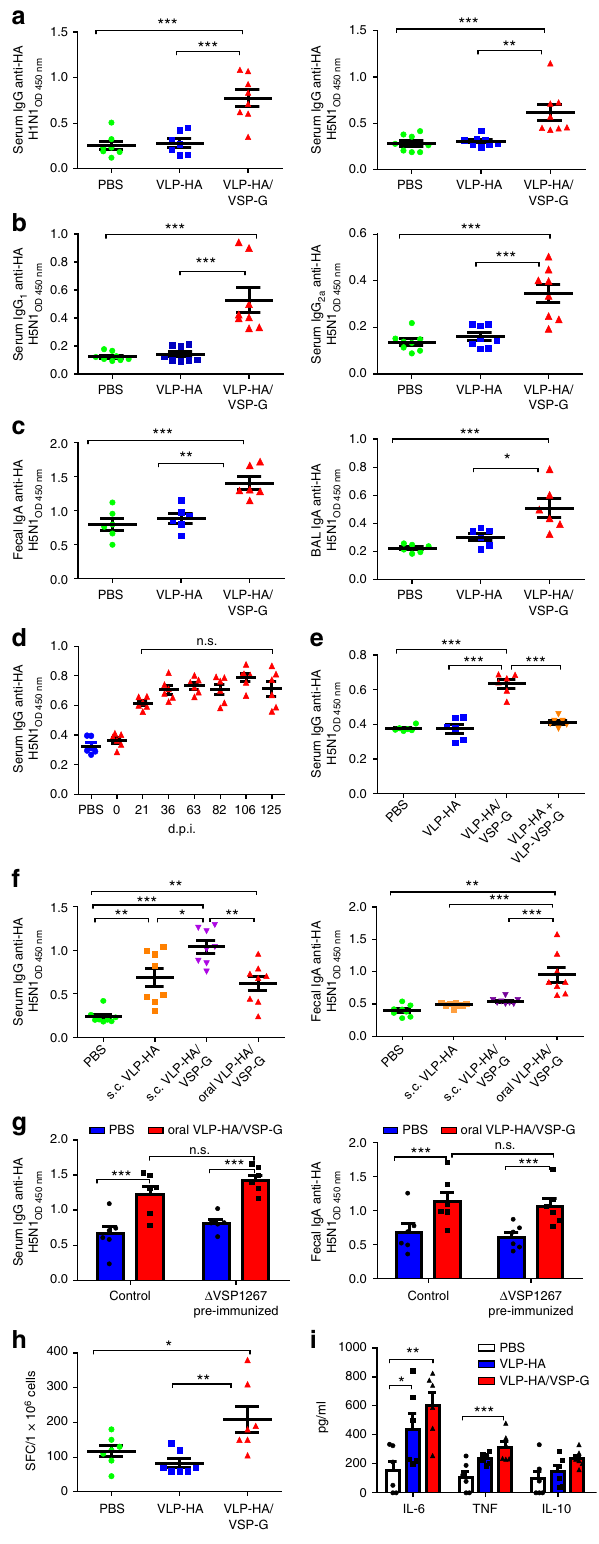
Fig. 5 Induction of anti-HA humoral and cellular responses in mice vaccinated with VLP-HA/VSP-G. a – e Mice were orally vaccinated with VLPs and the humoral response against HA in different biological samples was evaluated. Levels of total serum anti-HA IgG ( a ), IgG1 and IgG2a ( b ), n = 8 from two independent experiments. Levels of IgA anti-HA in fecal extracts and BAL, n = 6 from two independent experiments ( c ). Levels